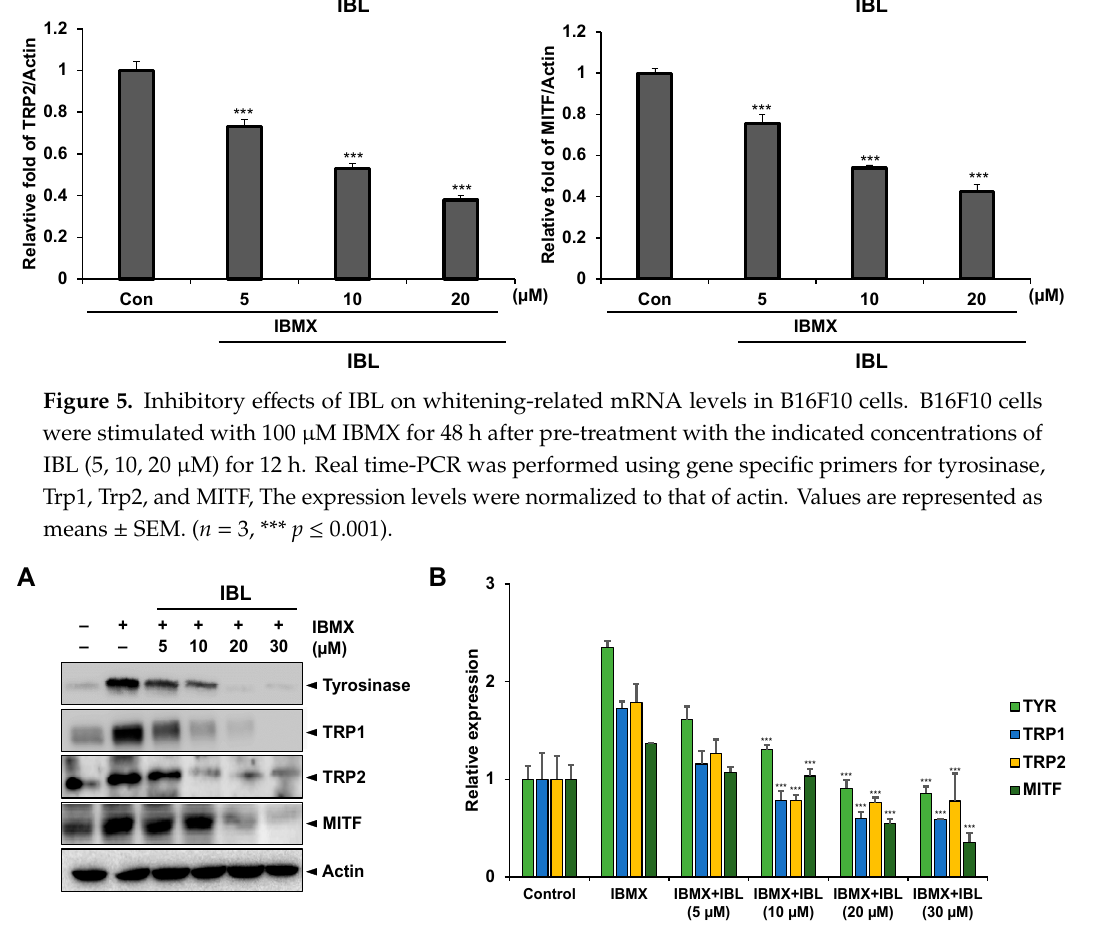
Figure 6. Inhibitory e ff ects of IBL on whitening-related protein expressions in B16F10 cells. ( A ) B16F10 cells were stimulated with 100 µ M IBMX for 48 h after pre-treatment with the indicated concentrations of IBL (5, 10, 20, 30 µ M) for 12 h. Western blotting was performed with specific antibodies for tyrosinase, TRP1, TRP2, and MITF. ( B ) Bar graphs of the relative expressions of tyrosinase, TRP1, TRP2, and MITF. The expression levels were normalized to that of actin. Values are represented as means ± SEM. ( n = 3, *** p ≤ 0.001).